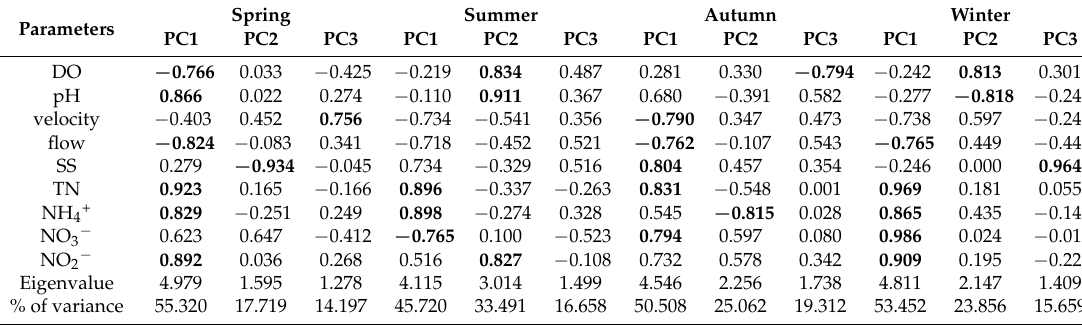
Table 4. PCA (principal component analysis) loadings, eigenvalues and percentages of variance explained for environmental parameters measured at all sampling sites across four